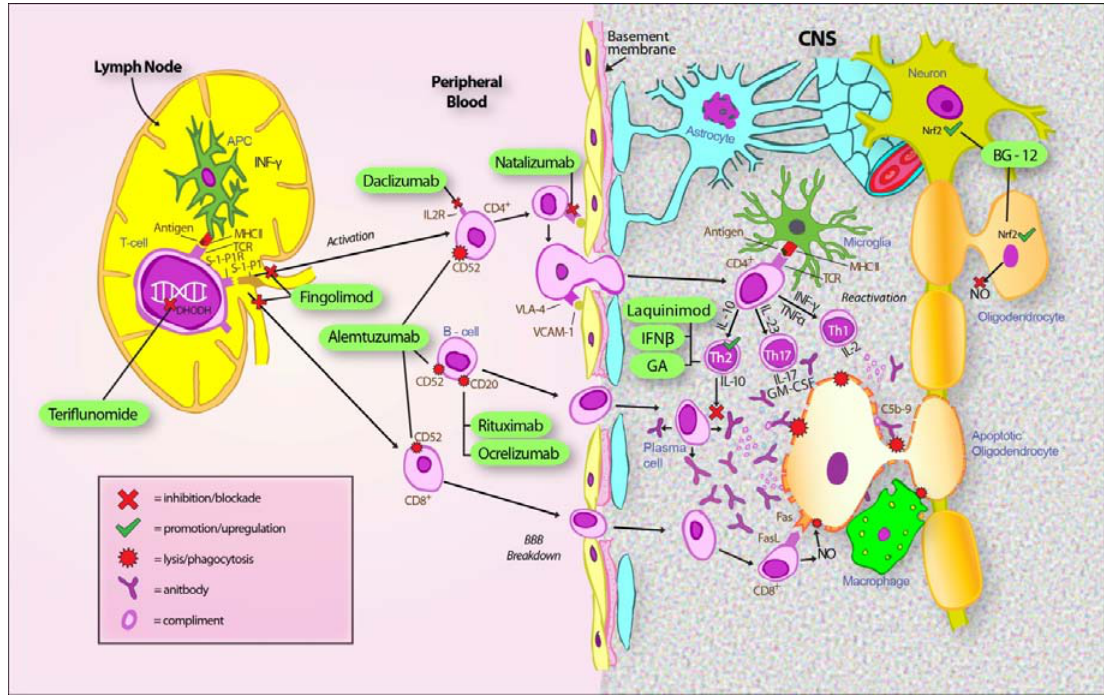
Figure 3. Schematic representation of multiple sclerosis (MS) pathophysiology indicating points of treatment intervention. APC antigen presenting cell; BBB blood brain barrier; C5b-9 complement complex 5b-9; CNS central nervous system; DHODH dihydroorotate dehydrogenase; FasL Fas ligand; GA glatiramer acetate; IFN interferon; IL2R interleukin 2 receptor; MHC I major histocompatibility complex I; NO nitrous oxide; Nrf2 nuclear factor (erythrocyte derived) related factor 2; S-1-P1 sphingosine-1-phosphate 1; TCR T cell receptor; VCAM-1 vascular cell adhesion molecule 1; VLA-4 very late antigen